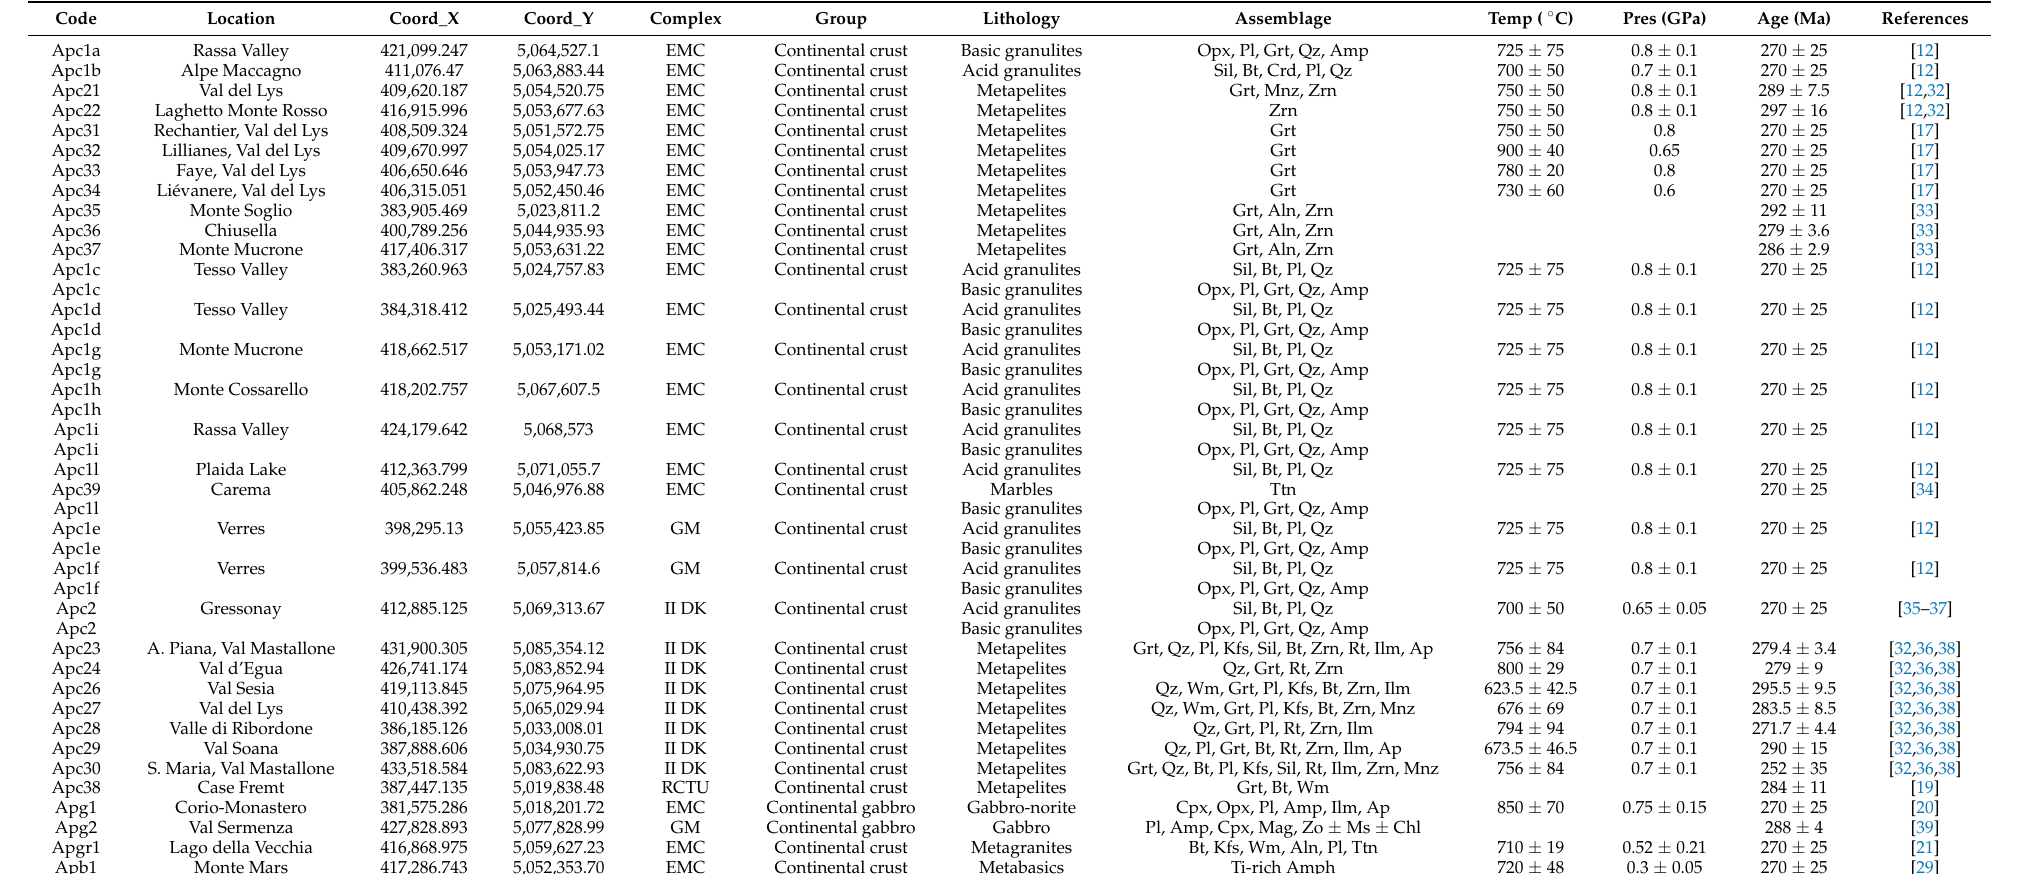
Table 1. Sample code, geographical location, tectonic unit, lithology, pre-Alpine mineral assemblage, PT estimate, ages (where present), and references for the Permian metamorphic samples and metaintrusives in the Sesia-Lanzo Zone. Apc = Austroalpine permian crust; Apg = Austroalpine permian gabbros; Apgr = Austroalpine permian metagranitoids. Mineral abbreviations after [31]. Coordinate system WGS84-UTM